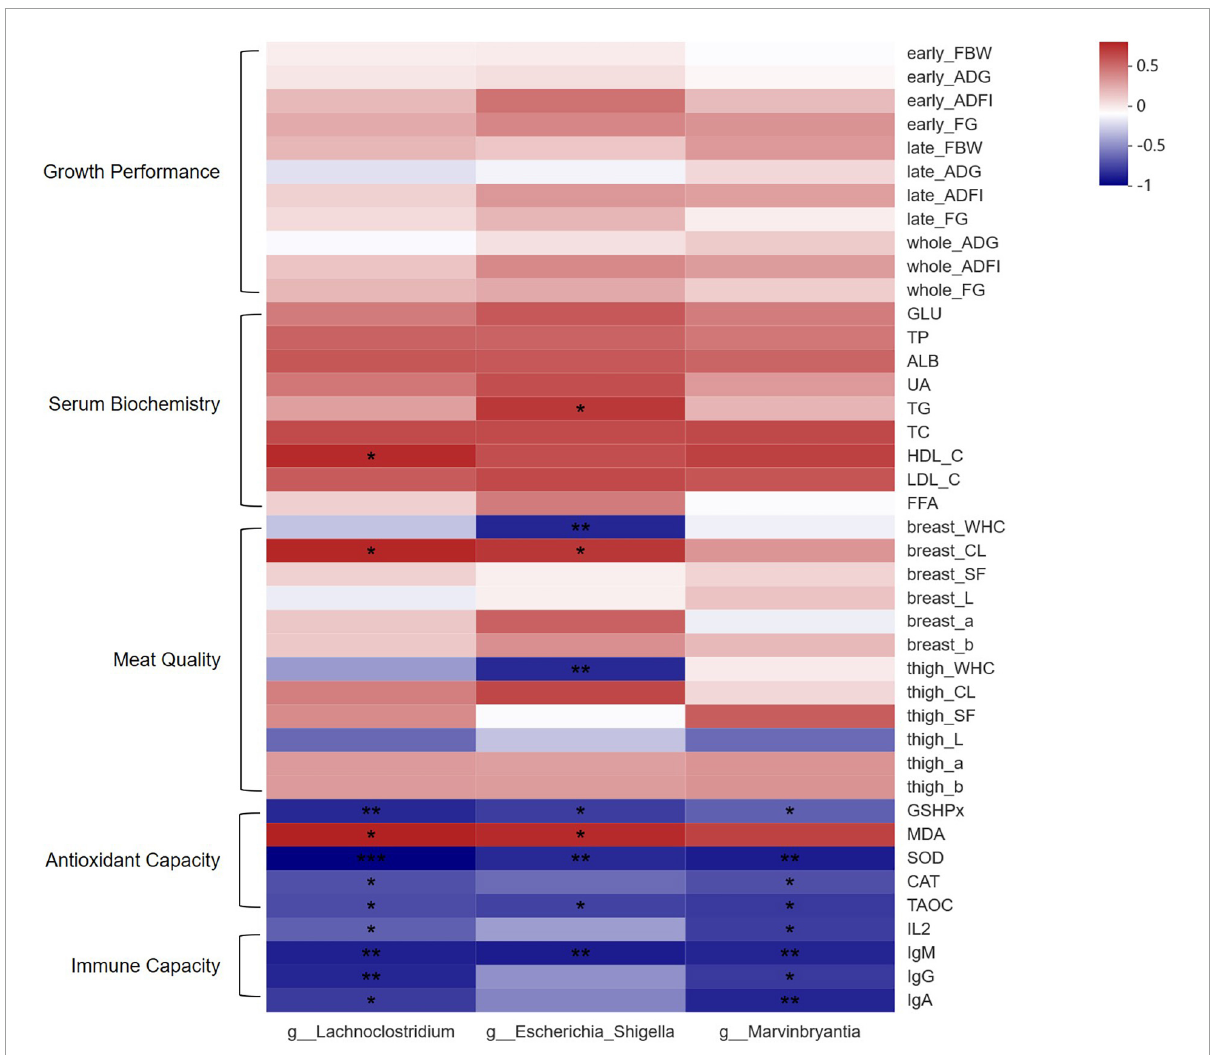
FIGURE5 Spearman correlation heatmap of significantly different microbiota between CON and RE750 and the measured parameters. The intensity of the colors demonstrated the degree of association (blue: negative correlation, red: positive correlation). Significant correlations were marked by * (0.01 < P ≤ 0.05), ** (0.001 < P ≤ 0.01), or *** (P < 0.001). FBW, final body weight; ADG, average daily weight gain; ADFI, average daily feed intake; FG, feed-to-gain ratio; GLU, glucose; TP, total protein; ALB, albumin; UA, uric acid; TG, triglyceride; TCHO, total cholesterol;